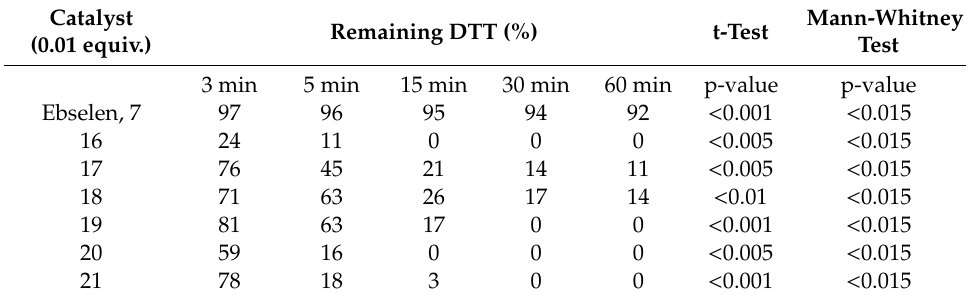
Table 2. Results of the antioxidant activity measurement – 0.01 eq. of Se-catalyst. Catalyst Remaining DTT (%) t-Test (0.01 equiv.)